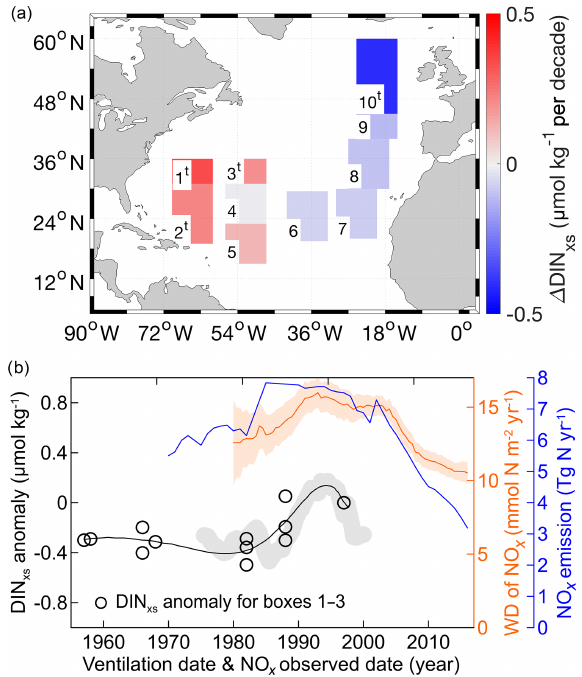
Figure 5. (a) The rates of (cid:49) DIN xs in the subsurface waters (200 − 600m) along the four transects between GO-SHIP and WOCE time periods (see Table S1). The study area is divided into 10 subregions of 10 ◦ longitude by 5–15 ◦ latitude along the tran- sects A22 (boxes 1–2), A20 (boxes 3–5), part of A05 (box 6), and A16N (boxes 7–10). The statistically significant changes (Student’s t test and ANOVA with Games–Howell test, p< 0 . 05) are marked with the superscript “ t ” for the box numbers. (b) Temporal varia- tions of DIN xs anomalies (open dots and their fitting curve) in the western NAtl in which the subsurface DIN xs increased significantly (boxes 1–3 in a ). Trend in DIN xs anomalies in the subsurface waters at the BATS site is shown in gray shading (the same as Fig. 3a). To ensure consistent comparisons between atmospheric N deposition rates and seawater DIN xs anomalies, the seawater DIN xs anomaly values were shifted backward by 15 years. The 15-year shift cor- responded to the mean time period that had elapsed since a given subsurface water mass had last been in contact with the atmosphere prior to subduction. The year that the subsurface water mass in the NAtl last had contacted the atmosphere was calculated using the CFC contents in that subsurface water. The orange curve and its shading show the 5-year moving average values of atmospheric wet deposition (WD) of NO x from the US Atlantic Coast and the range of the 95% confidence intervals, respectively (the monitoring sites are presented in Table S3). Blue curve indicates the NO x emission from the USA. The NO x emission strongly correlates with the WD of NO x ( r = 0 . 93, p< 0 .